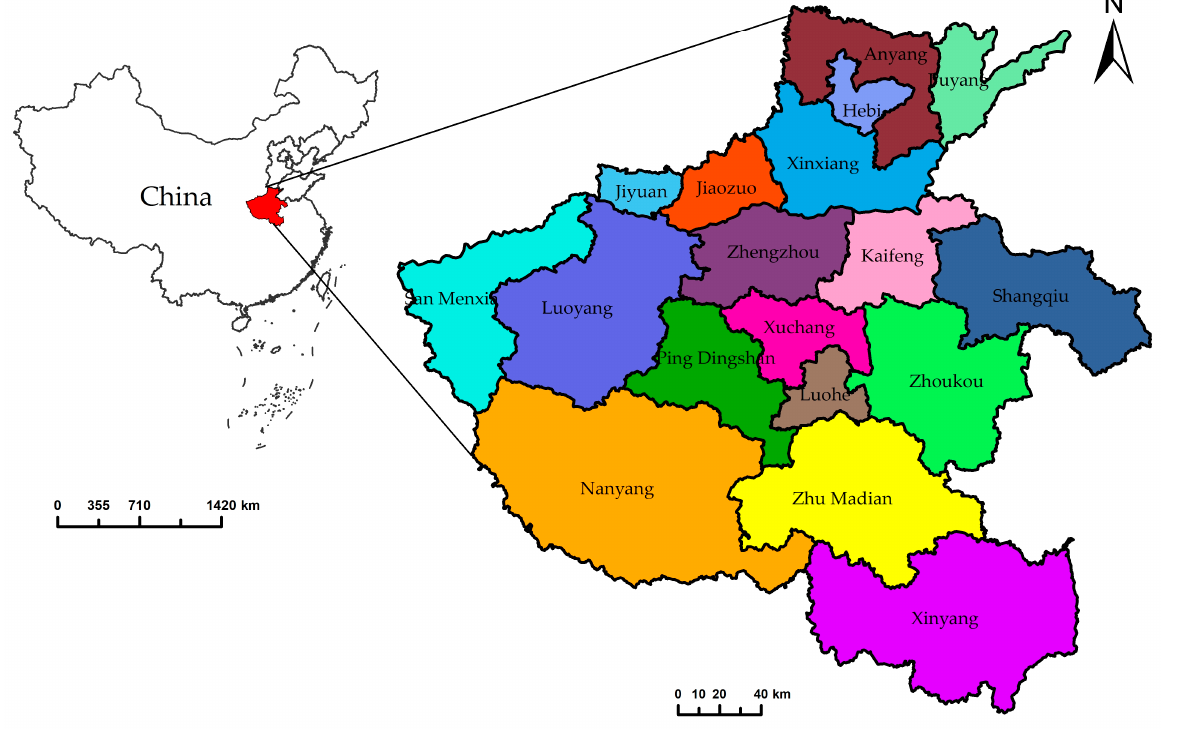
Figure 1. The 18 cities in Henan Province and the location of Henan Province in China.